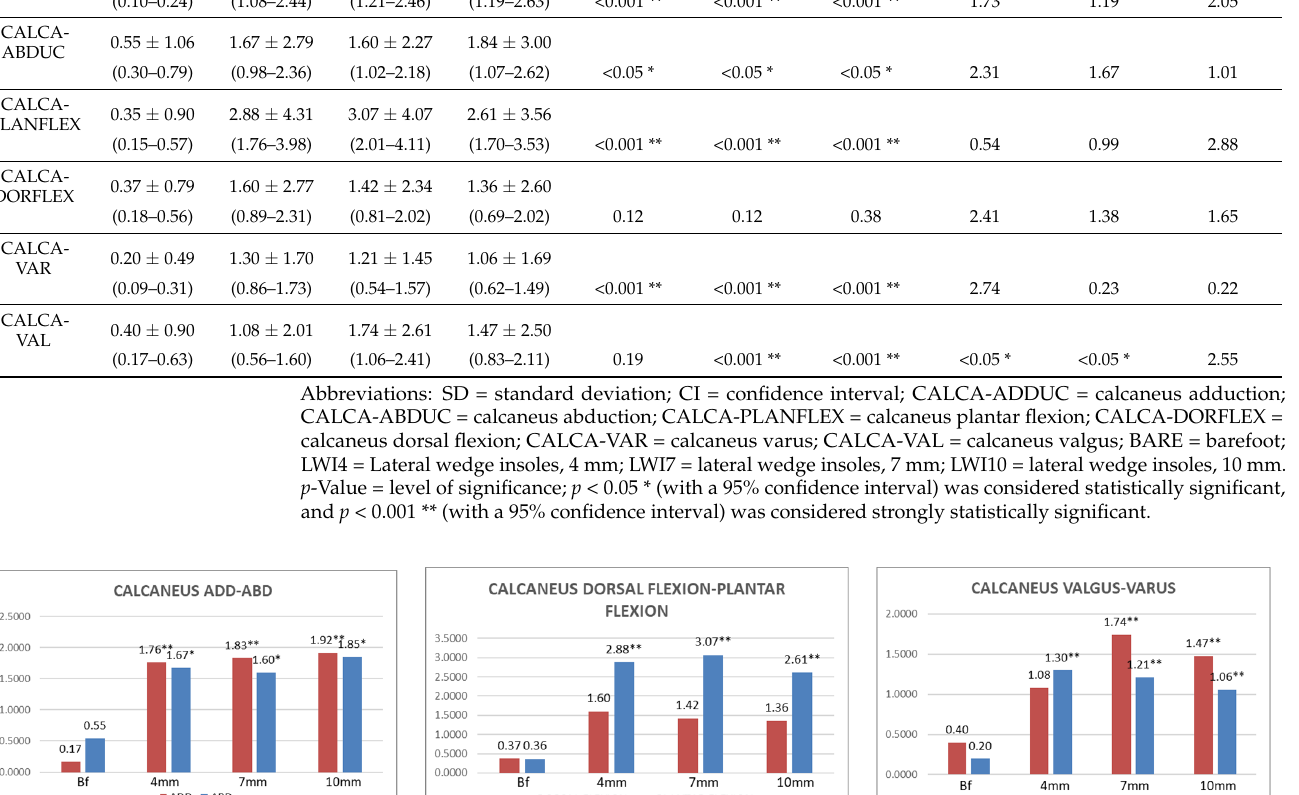
Table 6. The data of the calcaneus bone sensor movement under the four conditions.